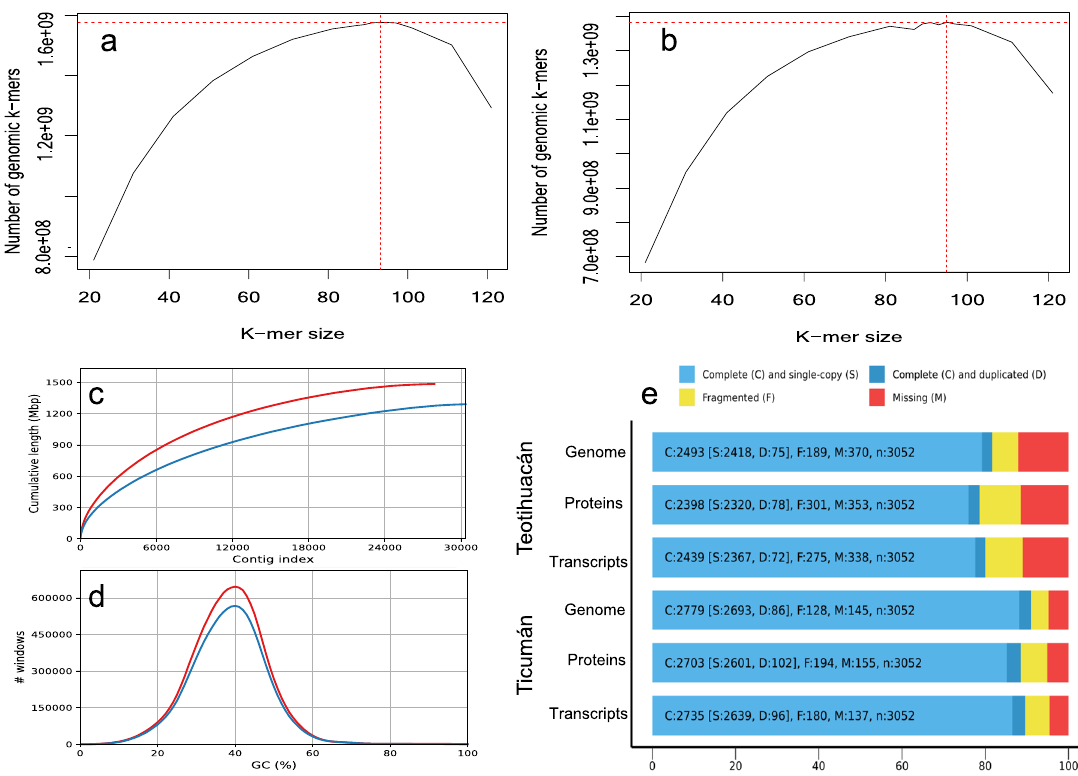
Figure 1. Genome size estimation in Datura stramonium by the K-mer distribution of the Illumina DNA reads ( a ) Ticumán, ( b ) Teotihuacán. ( c ) GC content plot shows the distribution of GC content in the contigs (red line = Ticumán, blue line = Teotihuacán). ( d ) Cumulative length plot shows the growth of contig lengths. On the x-axis, contigs are ordered from the largest to smallest. The y-axis gives the size of the x largest contigs in the assembly. This is the total genome assembled (red line = Ticumán, blue line = Teotihuacán). ( e ) BUSCO plots for the two Datura stramonium genomes, transcriptomes and proteomes predicted by MAKER program. The plot shows quantitative measures for the assessment of the genome completeness based on evolutionarily informed expectations of gene content from near-universal single-copy orthologs selected from the “Solanaceae odb10*” database. See Supplementary Table S3